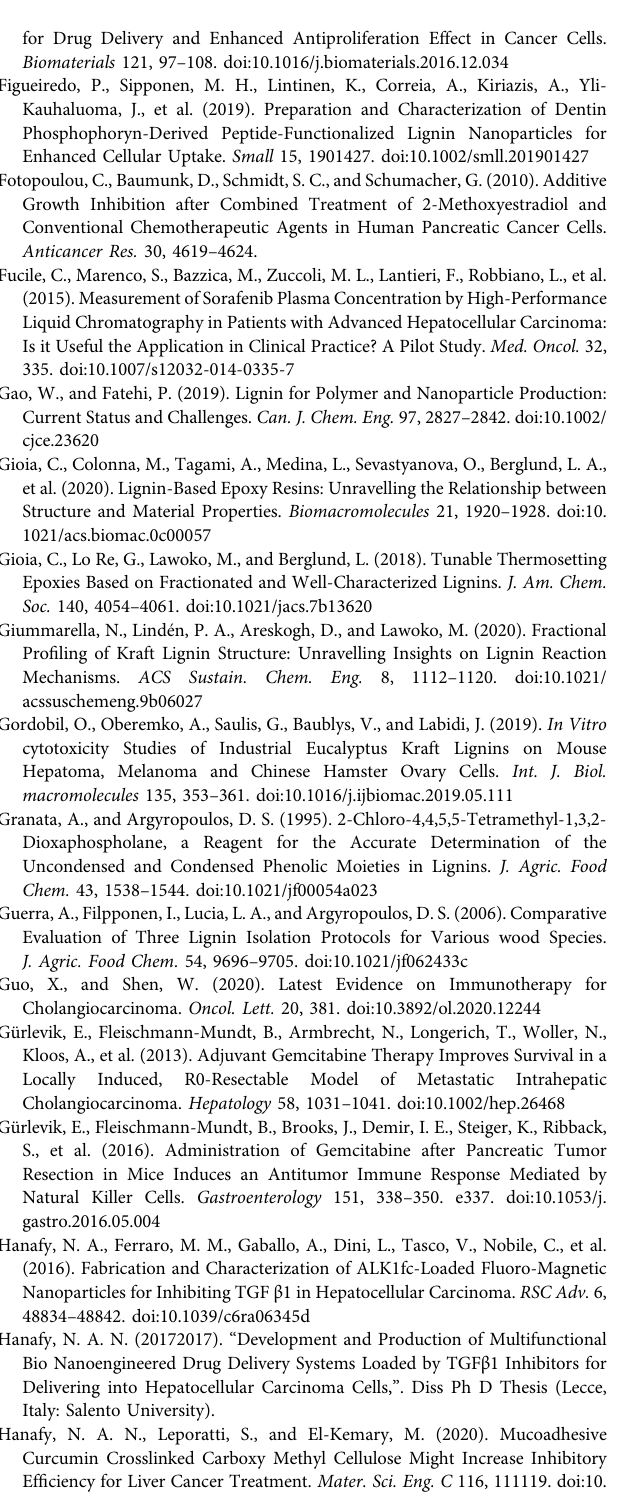
Figueiredo, P., Sipponen, M. H., Lintinen, K., Correia, A., Kiriazis, A., Yli- Kauhaluoma, J., et al. (2019). Preparation and Characterization of